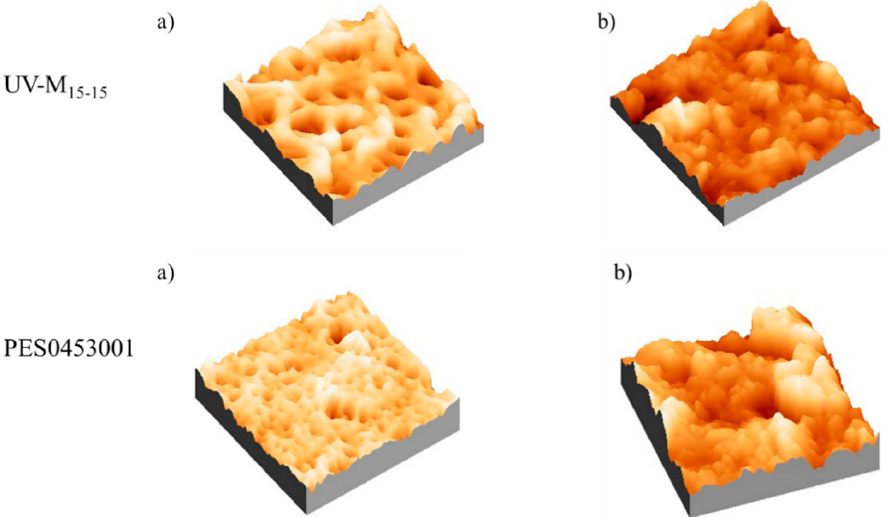
Figure 8. AFM images of the UV-M 15-15 and PES0453001 membranes, ( a ) before and ( b ) after the